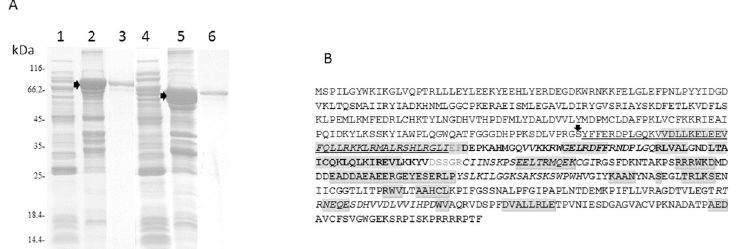
Fig 2. 2A. Acrylamide gel stained with Coomassie blue, showing the production and purification results for the recombinant antigens GST-Ag5t (1 to 3) and GST-DIPOL (4 to 6). 1, 4: Culture supernatants; 2, 5: culture pellets, 3, 6: purified proteins. The molecular weights are indicated on the left of the figure, and the position of each recombinant protein is indicated with arrows. 2B. Amino acid (aa) sequence of the recombinant protein GST-DIPOL. The arrow indicates the last aa of the GST tag protein. Sequences corresponding to each antigen are indicated underlined (AgB1), in bold (AgB2) and in shadowed characters (Ag5). Aa in grey correspond to the link between the three antigens. The predicted immunogenic epitopes are shown in italics and the alpha-helix structure is shadowed in grey.